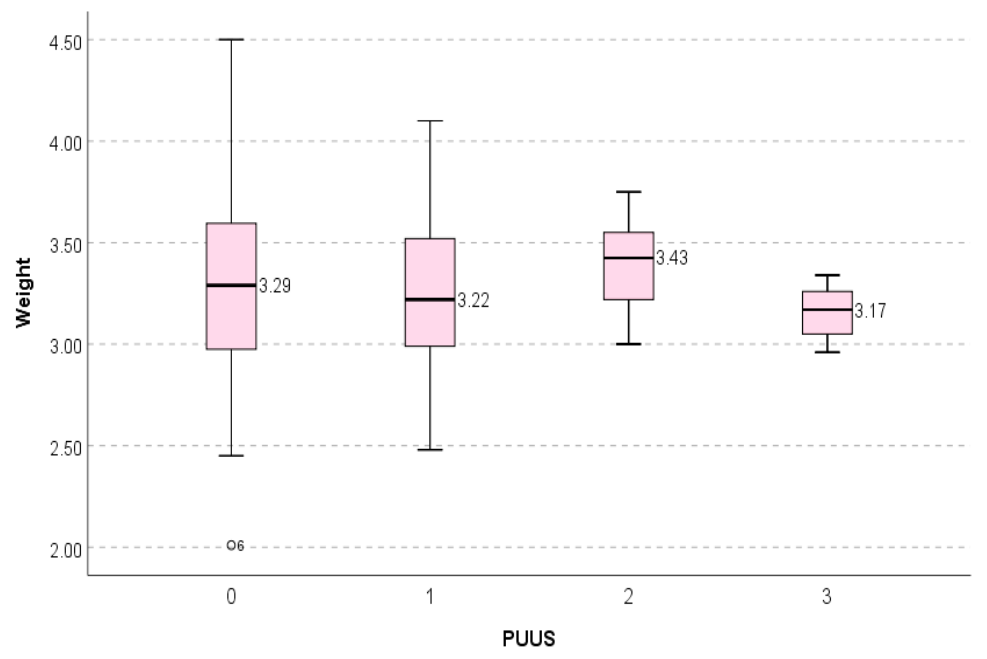
Figure 7. The PUUS grade did not vary significantly with the birth weight. Weight was constant when PUUS = 4; therefore, it was omitted from the statistical analysis.